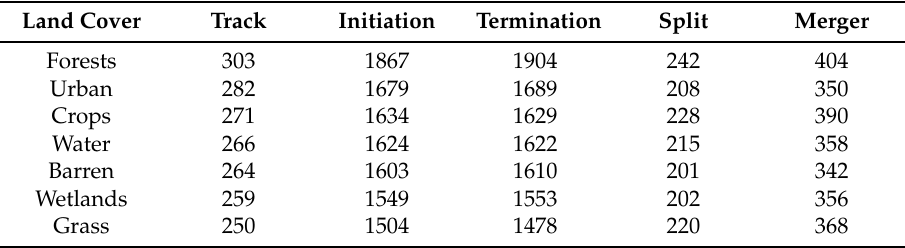
Table 1. The densities of thunderstorm track (km/km 2 ), initiation (count/km 2 ),